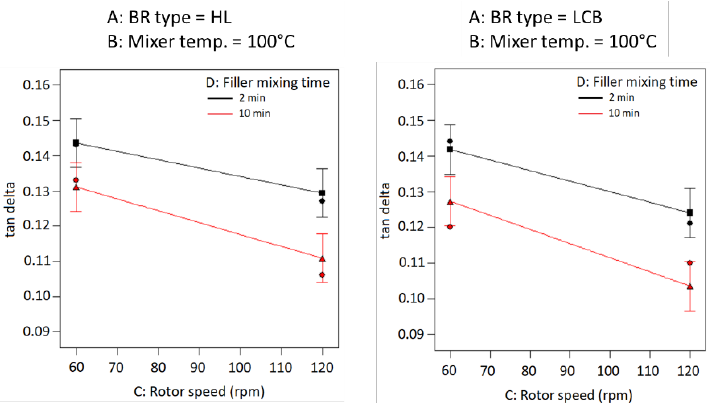
Figure 8. Interaction plot between rotor speed and filler mixing time on tan delta in rubber compounds Figure 8 . Interaction plot between rotor speed and filler mixing time on tan delta in rubber Figure 8 . Interaction plot between rotor speed and filler mixing time on tan delta in rubber containing HL-BR and LCB-BR. Figure 8 . Interaction plot between rotor speed and filler mixing time on tan delta in rubber compounds containing HL-BR and LCB-BR . compounds containing HL-BR and LCB-BR . compounds containing HL-BR and LCB-BR .